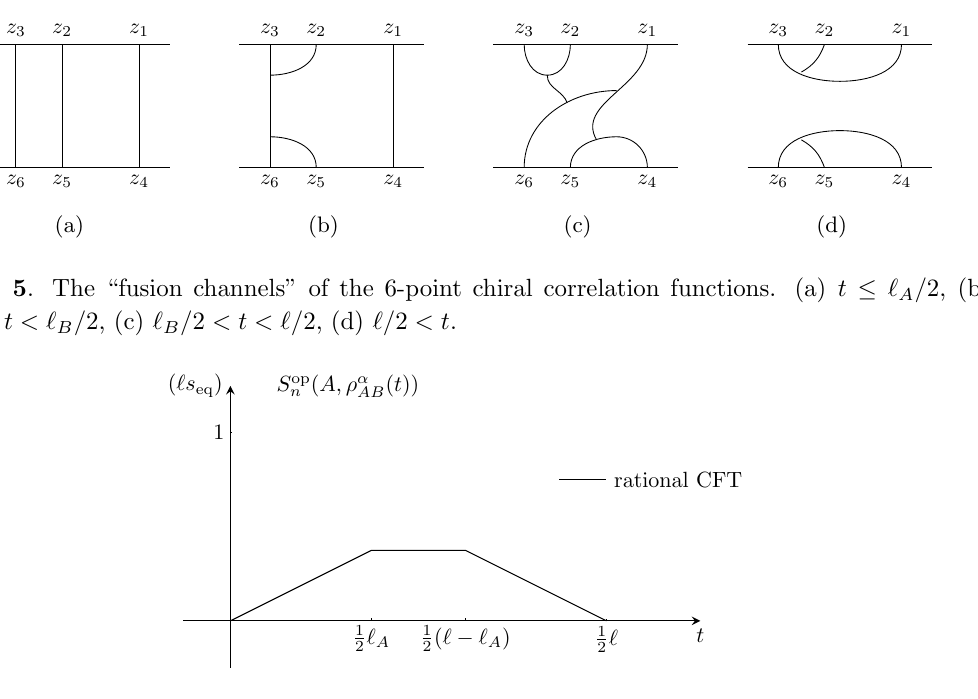
Figure 6 . Results of rational conformal (cid:12)eld